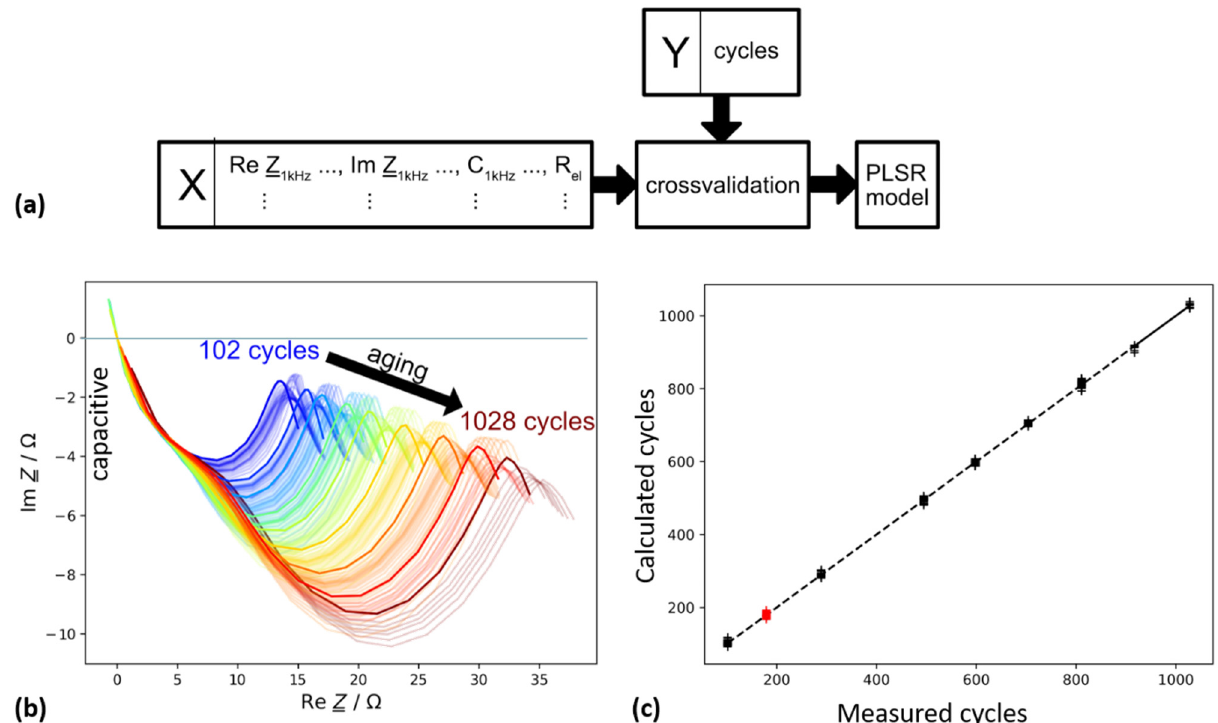
Figure 11. ( a ) Multilinear regression model. ( b ) Impedance spectra of a Sanyo/Panasonic 18,650 cell (LCO chemistry) during cycle aging (DOD 100%), mathematical convention. Thick lines: SOC 100%. Thin lines: SOC 95%, 90%, . . . , 30%. ( c ) Calculated cycles with PLSR model against real cycles. Red: Prediction for a different test sample (179 cycles) of the same battery chemistry and